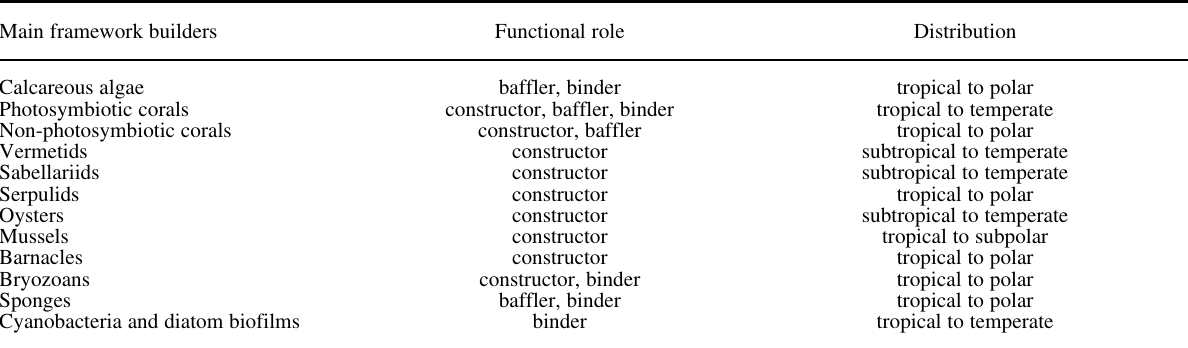
TABLE 1. – Main framework builders, their functional role in the bioconstruction process and their global distribution. Main framework